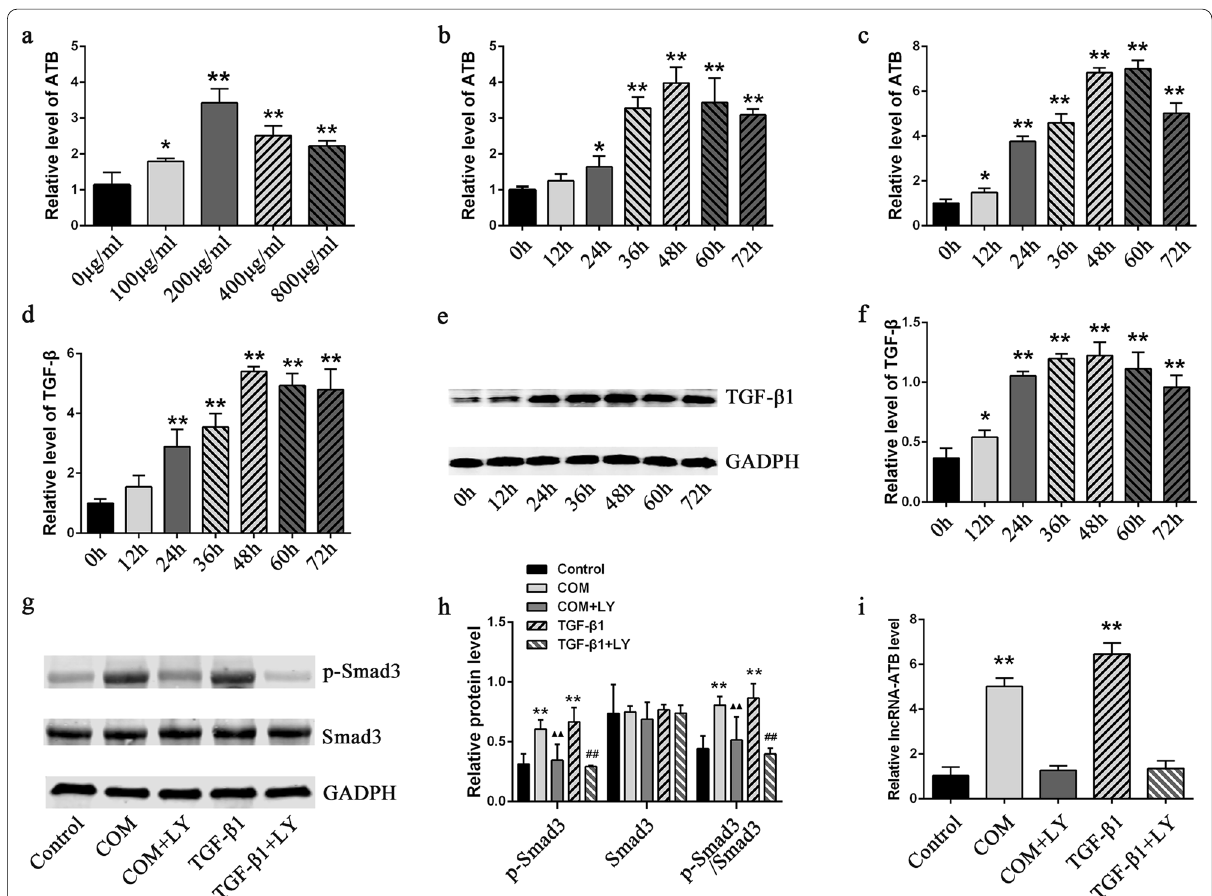
Fig. 1 The expression levels of lncRNA-ATB and TGF-β1 in cell models. a – c LncRNA-ATB expression levels in HK-2 cells exposed to different-concentration COM for 48 h ( a ), to 200ug/ml COM for different hours ( b ), and to 10 ng/ml TGF-β1 for different hours c by qRT-PCR. d , e TGF-β1 expression levels in HK-2 cells exposed to 200ug/ml COM for different hours by qRT-PCR d and by Western bolting ( e ), f Quantitative results of TGF-β1 protein levels. g The Smad3 phosphorylation levels were detected by Western bolting. h Quantitative results of p-Smad3 or Smad3 expression levels. i LncRNA-ATB expression levels in HK-2 cells after the inhibition of the TGF-β1 receptor by LY2109761 All above the experiments were repeated 3 times, values are mean SD. * P < 0.05, ** P < 0.01 VS . 0ug/ml or 0H or control group, ▲▲ P < 0.01 vs. COM group, ## P < 0.01 VS. ± TGF-β1